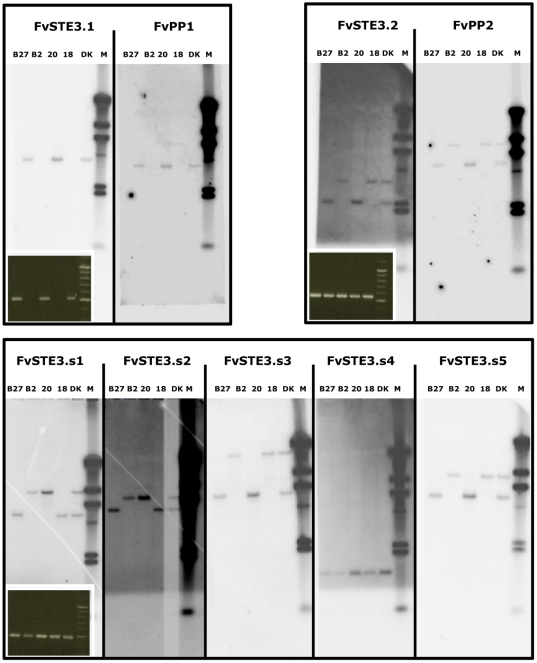
Distribution of pheromone receptors and pheromones in matB3 and matB4 loci.Southern blots confirmed the PCR distribution patterns of the pheromone receptors and pheromones in dikaryon KACC43778; A3B3A4B4 (DK), strain KACC43777; A4B4, (B18), KACC 42780; A3B3, (B20) and two monokaryotic siblings 4019-B2; A3B4, (B2) and 4019-B27; A4B3, (B27). Pheromone receptor FvSTE3.1 and pheromone FvPP1 are exclusively detected in strains containing the matB3 locus (B20 and B27), and as a single copy in the dikaryon (DK). The small, equally sized signals for FvSTE3.s4 on the Southern blot are caused by an internal SacI restriction site in this gene. PCR detection patterns for FvSTE3.1, FvSTE3.2 and FvSTE3.s1 are inserted as panels in the bottom of the Southern analyses. Strains that contained a copy of a gene invariably generated a specific PCR product. No false products were amplified with our primers. Pheromone receptor FvSTE3.2, FvSTE3.s1 to FvSTE3.s5 and pheromone receptors FvPP2 and FvPP3 were detected in matB3 and matB4 mating-types.